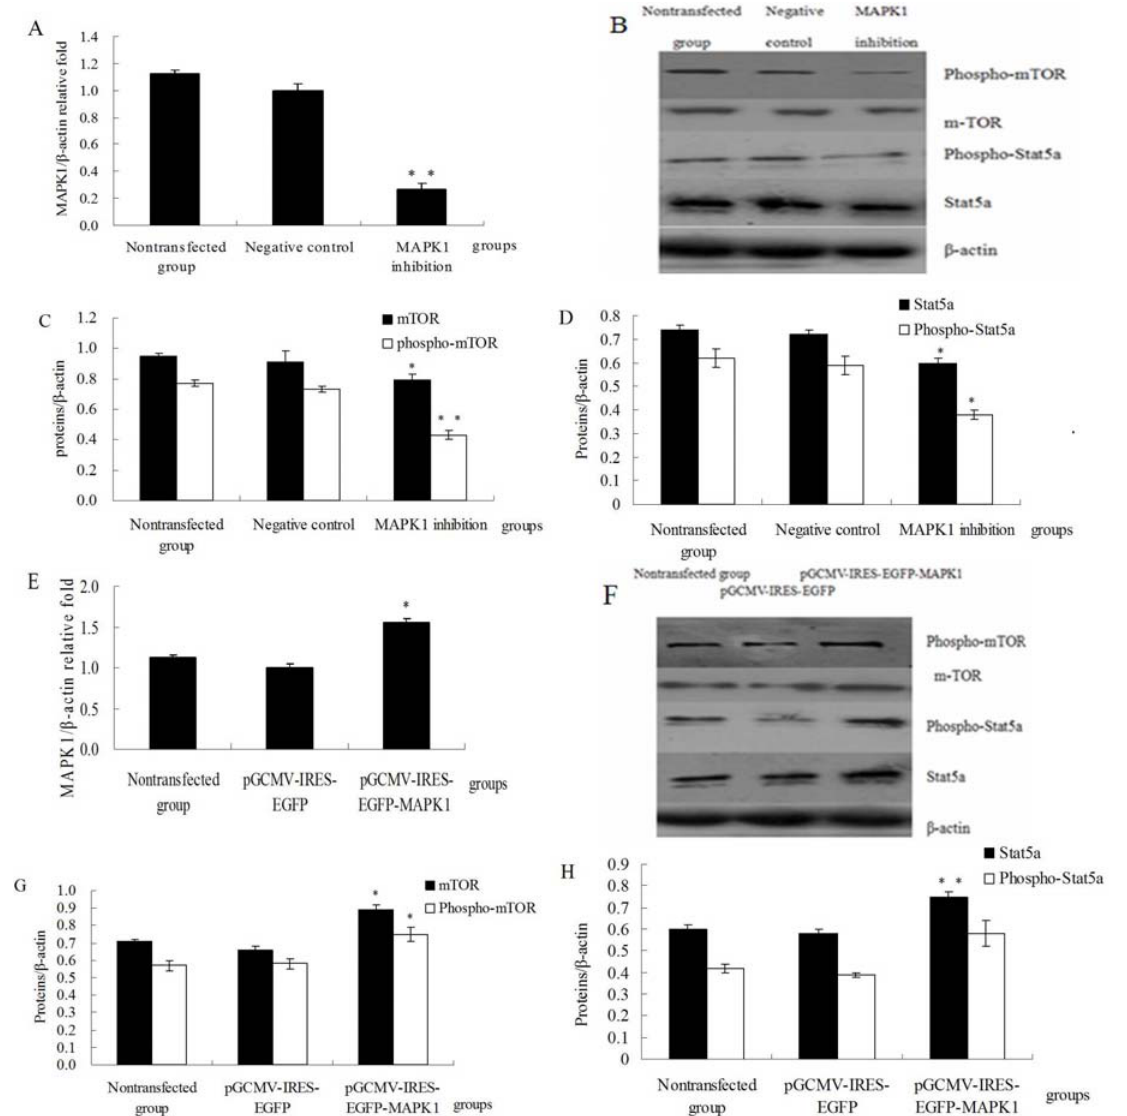
Figure 3. MAPK1 up-regulated expression of Stat5a and mTOR ( A ) Relative mRNA expression of MAPK1 was determined by qRT-PCR after MAPK1 inhibition; ( B ) Western blotting results of phospho-Stat5a, Stat5a, phospho-mTOR, mTOR and β -actin after MAPK1 inhibition; ( C ) Results of gray scale scan of phospho-mTOR, mTOR/ β -actin relative fold by western blotting after MAPK1 inhibition; ( D ) Results of gray scale scan of phospho-Stat5a, Stat5a/ β -actin relative fold by western blotting after MAPK1 inhibition; ( E ) Relative mRNA expression of MAPK1 was determined by qRT-PCR after over-expression of MAPK1; ( F ) Western blotting results of phospho-Stat5a, Stat5a, phospho-mTOR, mTOR and β -actin after over-expression of MAPK1; ( G ) Results of gray scale scan of phospho-mTOR, mTOR/ β -actin relative fold by western blotting after over-expression of MAPK1; ( H ) Results of gray scale scan of phospho-Stat5a, Stat5a/ β -actin relative fold by western blotting after over-expression of MAPK1. Values are means ± SE (n = 3 per group, biological replicates). * and ** indicate significant differences from values obtained in the negative control group or the pGCMV-IRES-EGFP empty vector group at levels of p < 0.05 and p < 0.01,